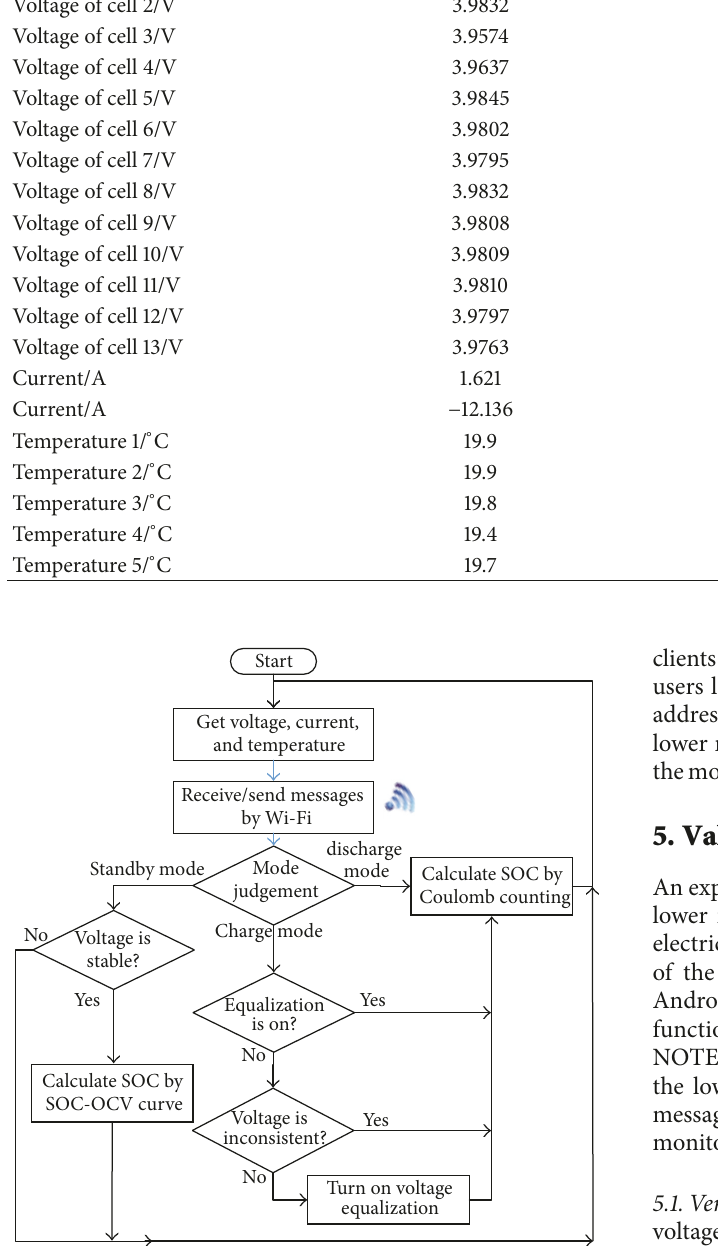
Figure 7: Control flow of the lower